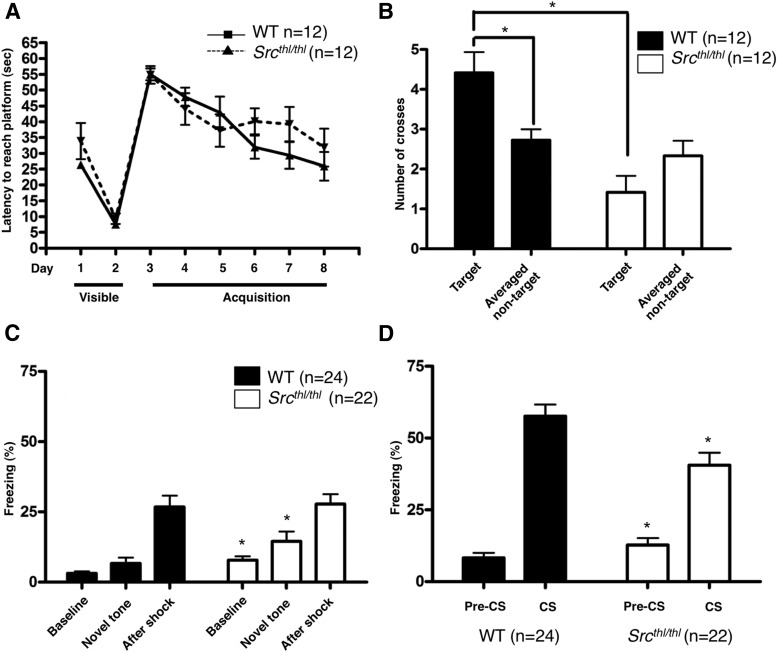
Impaired memory in Srcthl/thl mutant mice. A, Mice were assessed in the Morris water maze procedure (n = 12 WT (12 males), n = 12 Srcthl/thl (12 males)). Mean latency to reach a target platform in a visible platform session (days 1 and 2), and in a hidden-platform acquisition phase (days 3-8). B, Spatial memory retention was assessed in the probe trials administered 2 h after day 8 (n = 12 WT (12 males), n = 12 Srcthl/thl (12 males)). Mean number of platform crosses during probe trial 1 are shown. *p < 0.05. C, Freezing (as a percentage of total time) in a novel conditioning chamber (n = 24 WT (13 males, 11 females), n = 22 Srcthl/thl (12 males, 10 females)). After recording baseline freezing for 120 s, a tone was presented for 30 s (novel tone), after which mice were given a footshock and left inside the chamber for another 30 s (after shock). A subtle increase in freezing was observed during baseline and novel tone presentation in Srcthl/thl mice. *p < 0.05. D, Cued fear memory 24 h after pairing (n = 24 WT (13 males, 11 females), n = 22 Srcthl/thl (12 males, 10 females)). Pre-CS is freezing in the absence of the tone in a novel context, while CS is percentage freezing during tone presentation. Srcthl/thl mice showed impaired auditory fear conditioning, however, context was not affected. Data are presented as mean ± SEM, *p < 0.05.